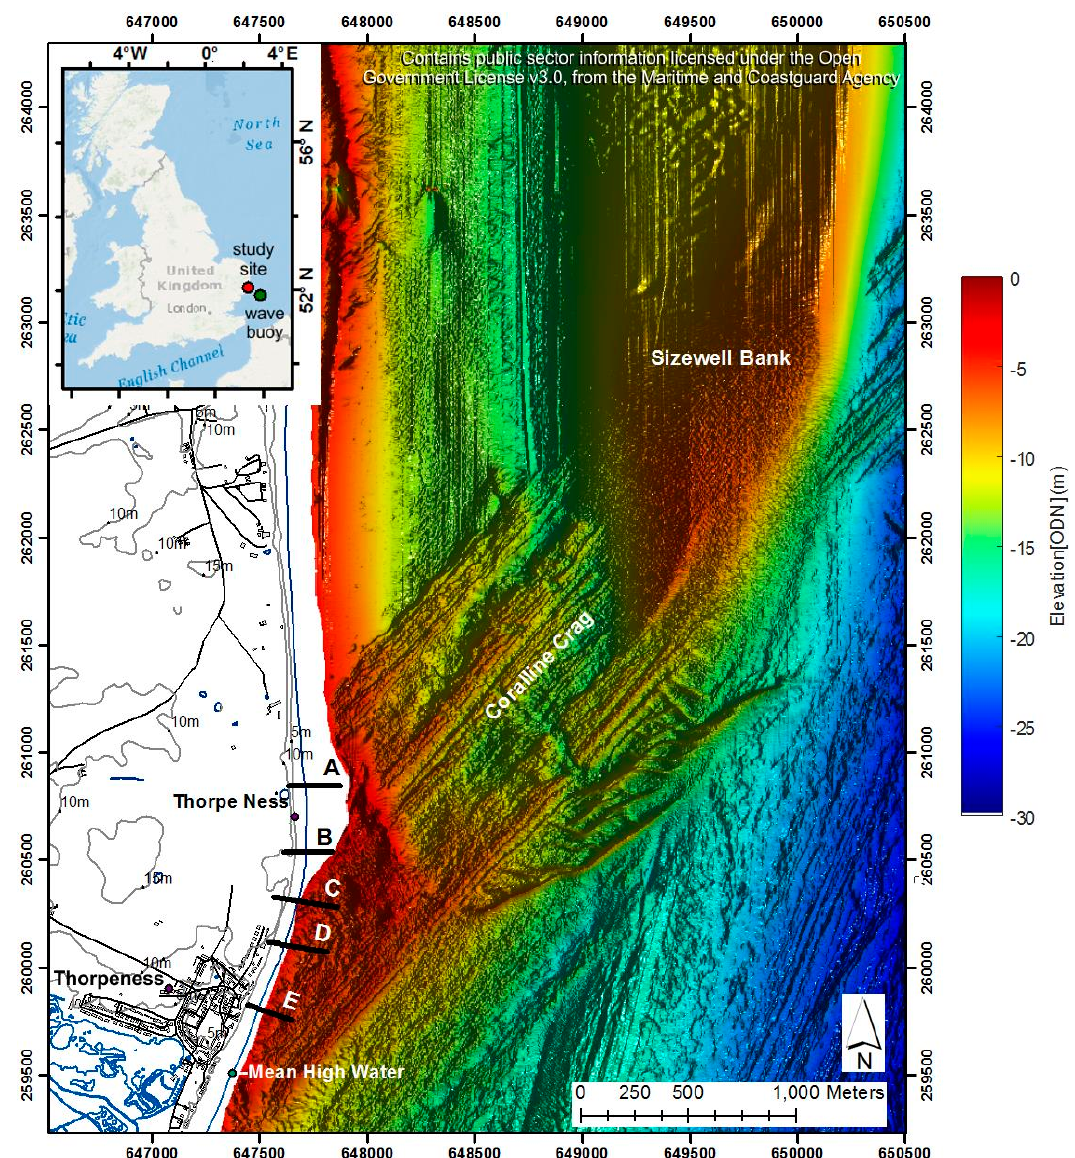
Figure 1. Location of beach transects between Thorpeness village (south) and Sizewell nuclear power station (north) in Suffolk (East Anglia, United Kingdom), and offshore bathymetry measured in January